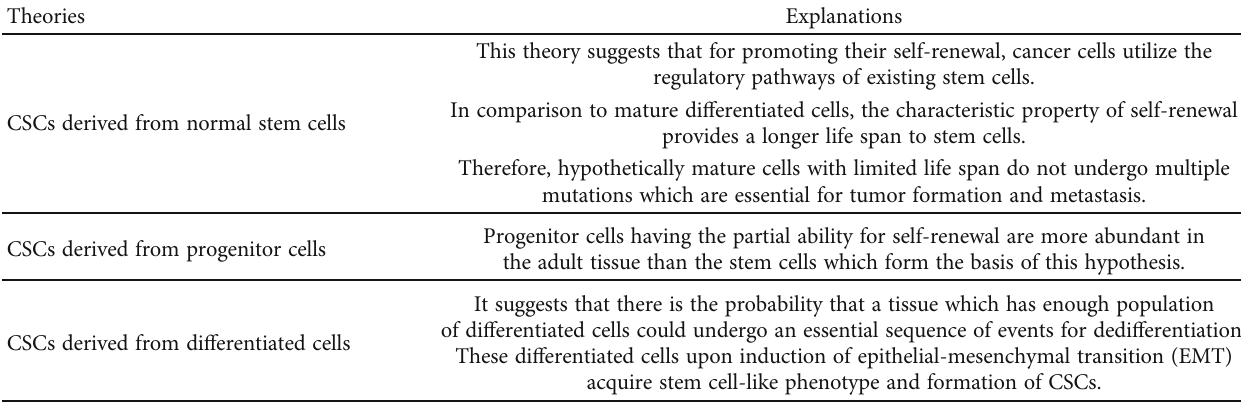
Table 2: Theories suggesting origin of CSCs [11,